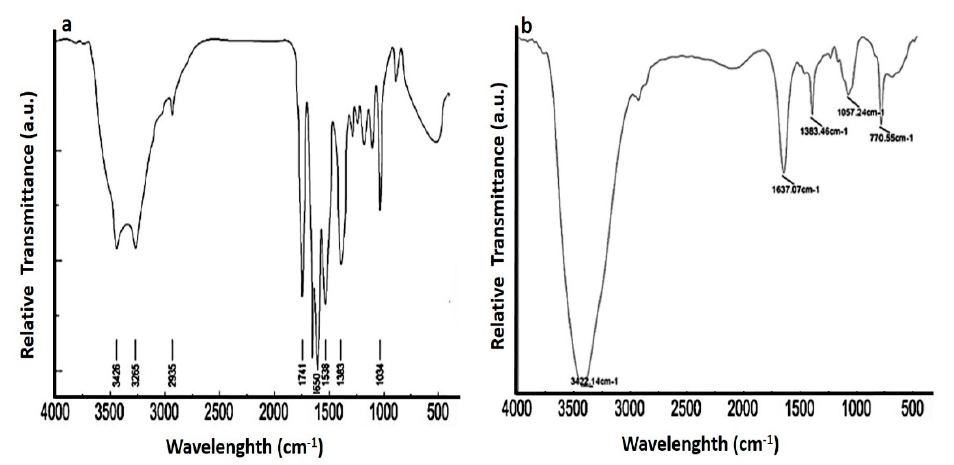
Figure 6. FTIR spectra of ( a ) pure ceftriaxone and ( b ) CGNPs.